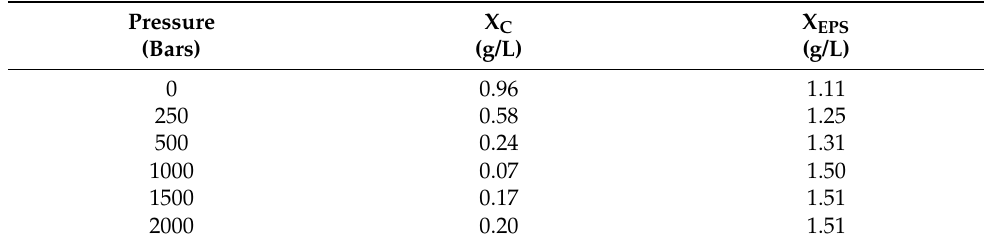
Table 1. Microalgal cells dry weight (Xc) and extracellular polysaccharides dry weight (X EPS ) in supernatants after homogenization under different pressures followed by centrifugation.